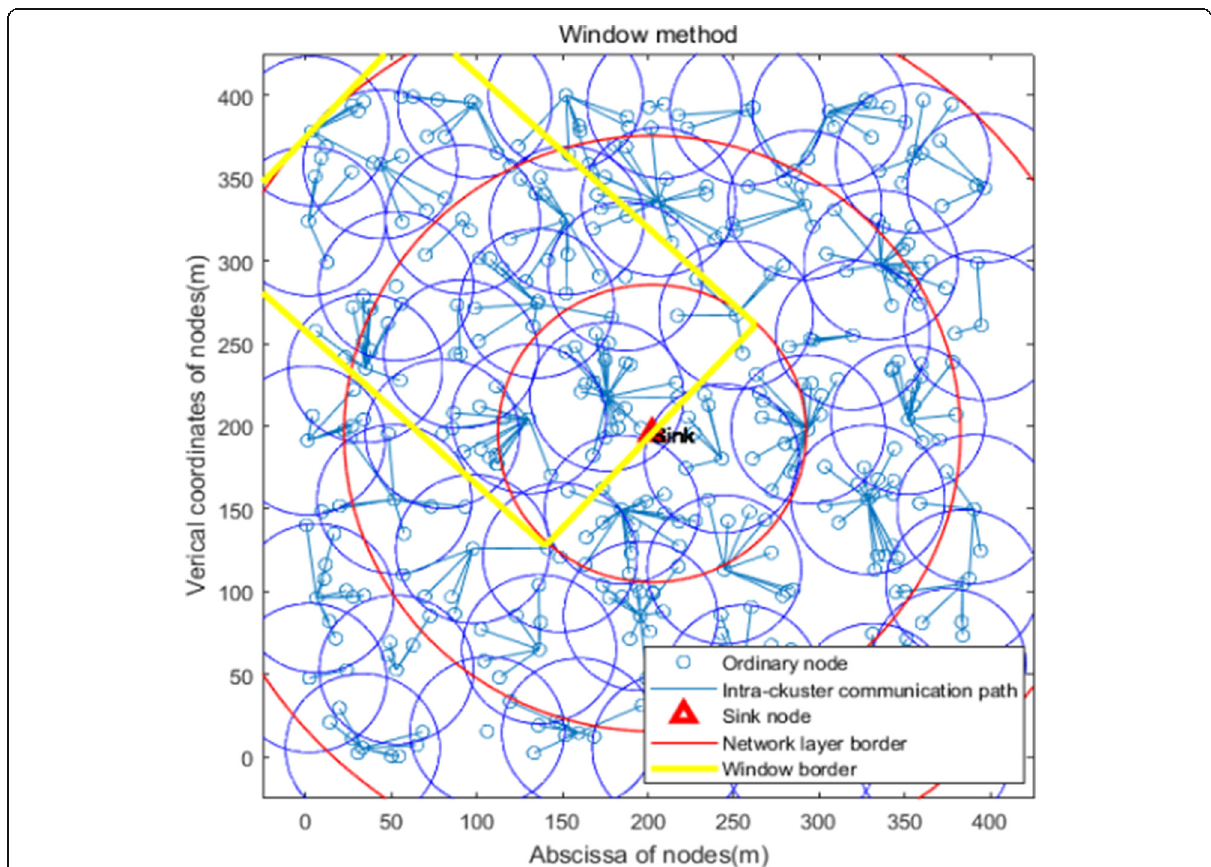
Fig. 5 Window screening mechanism. Nodes within the yellow box are selected by windows screening mechanism